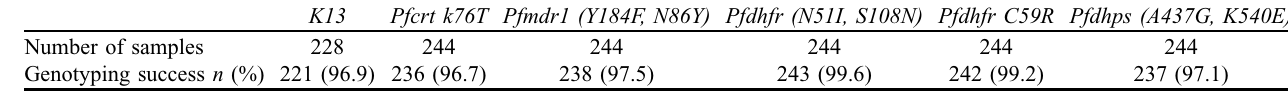
Table 1. PCR sensitivity for mutation points analyzed in different Plasmodium falciparum